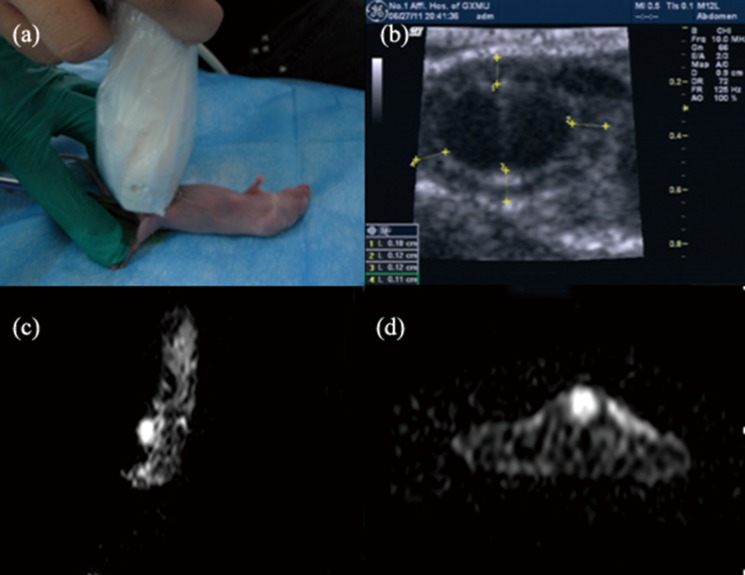
Color Doppler and MRI detection of bladder cancer.(a) The color Doppler ultra-wide-range linear-array transducer with frequency 12 MHz was used to scan the bladder of BALB/c-nu mice. (b) Color Doppler showed bladder filled well and thickening of the bladder wall. (c, d) MRI detected thickening of the bladder wall and various degrees of bladder filling defects.